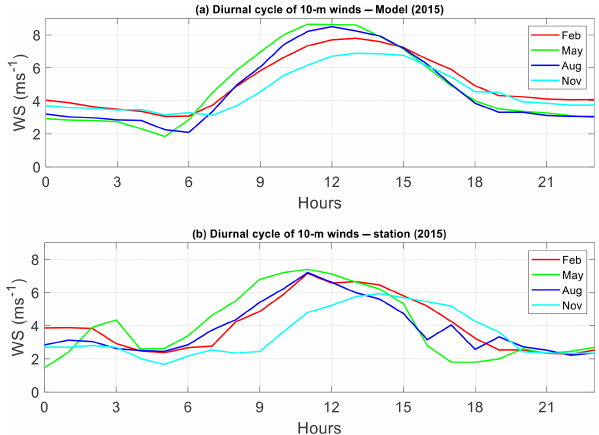
Figure 3. (a) Average diurnal cycle (2015) of 10m winds at KAUST for four different months representing each season from (a) model and (b) station. Times are reported in UTC.